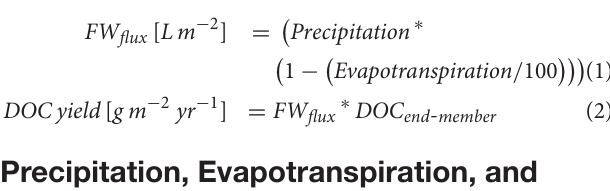
Frontiers in Earth Science |